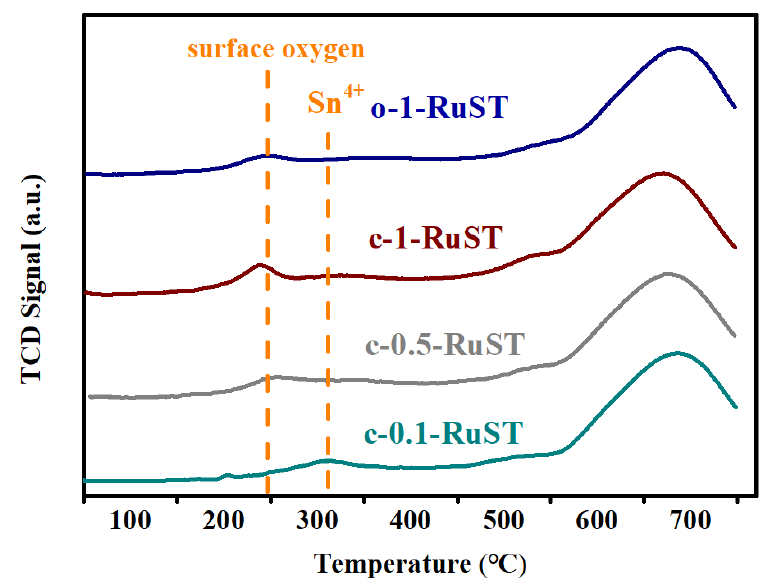
Figure 7. H 2 -TPR profiles of the catalysts. The reduction peak positions of Sn 4+ and oxygen species on the catalyst surface are also marked in the figure.